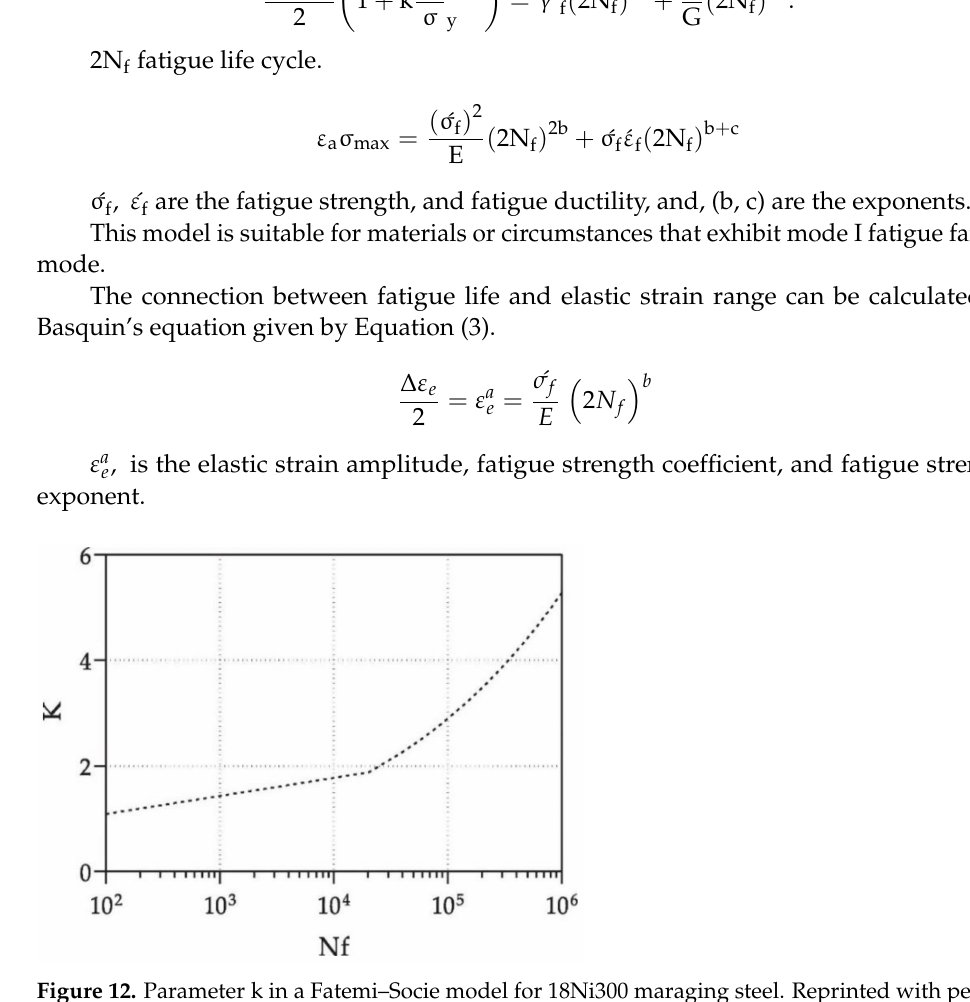
Figure 12. Parameter k in a Fatemi–Socie model for 18Ni300 maraging steel. Reprinted with permis- sion from ref. [71]. 2022,